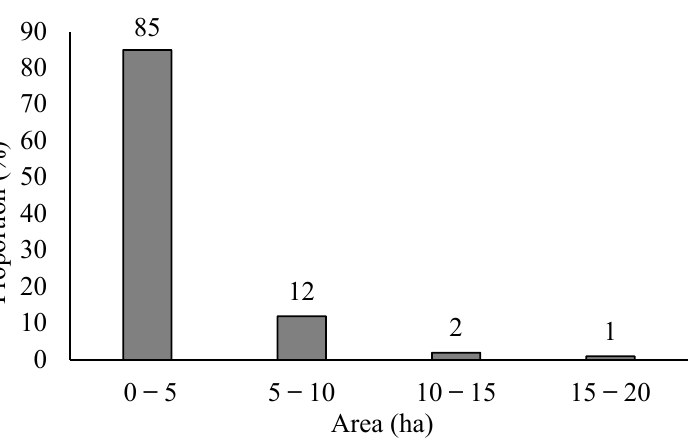
Figure 13. Age of cocoa farms in Biankouma region.